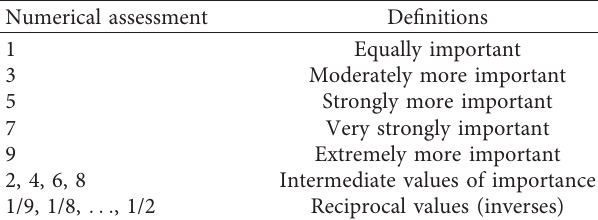
Table 3: AHP scale of nine points used in the paired comparatives.